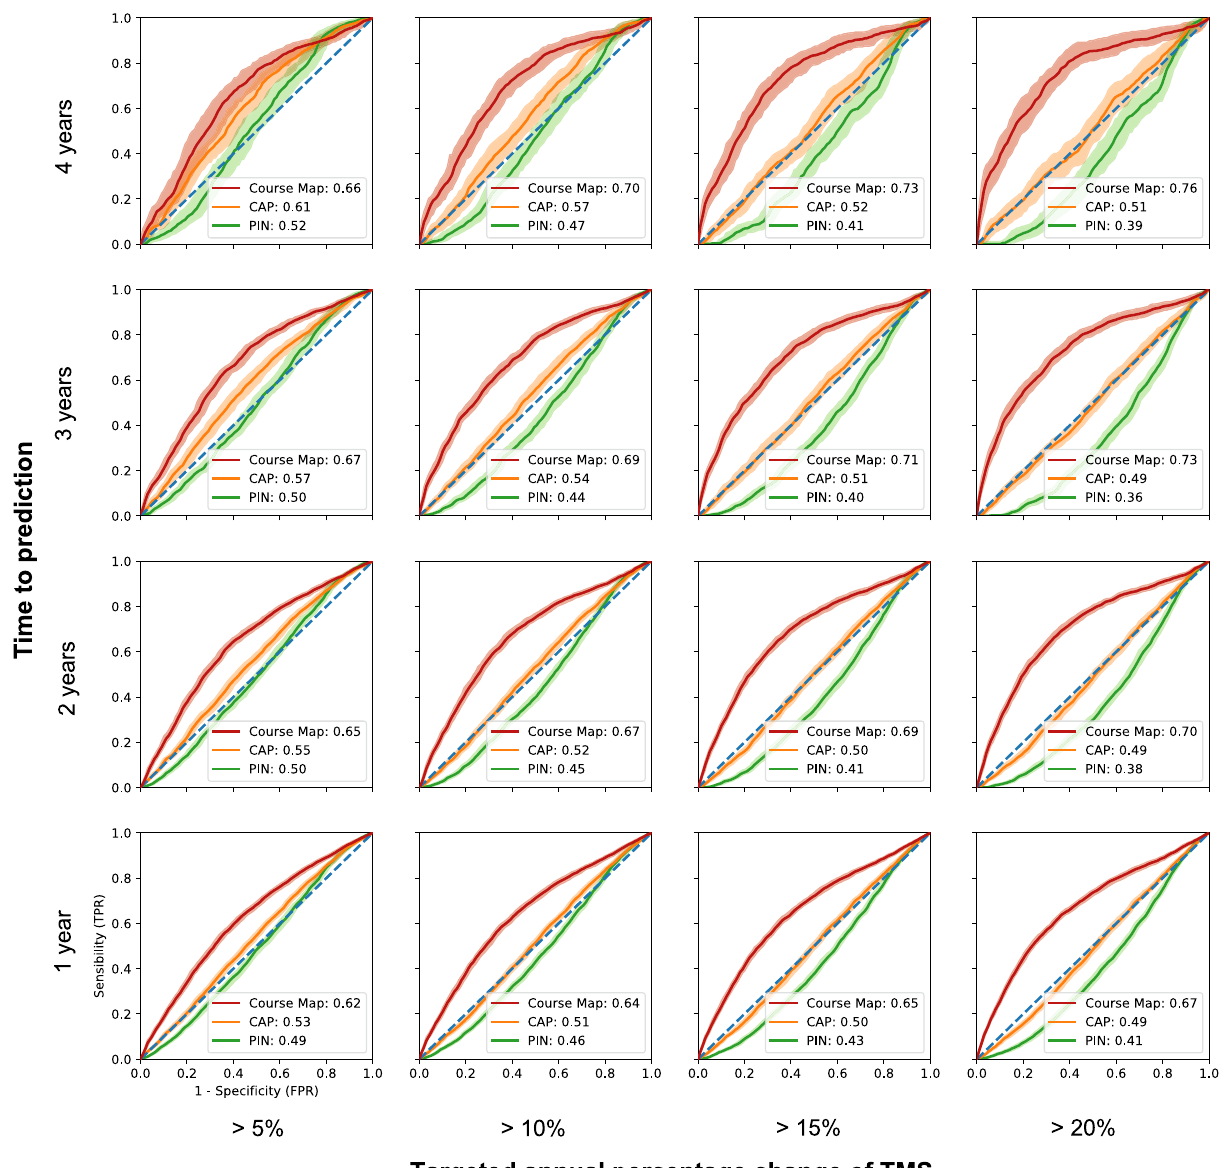
Figure 5. HD COURSE MAP identifies participants with TMS increase. ROC curves are shown for the detection of participants with an annual percentage change of TMS of at least 5%, 10%, 15% or 20% (in columns) in 1, 2, 3 or 4 years (in rows). Selection was made for ENROLL participants whose baseline TMS value has already diverged from controls. Three methods are compared: selection based on PIN, CAP and the TMS change from baseline that HD COURSE MAP predicts. AUCs for the three methods are reported in the